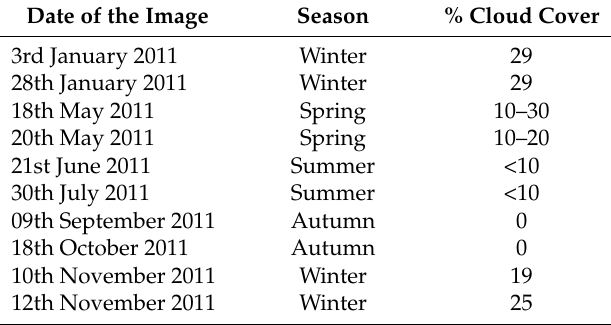
Table 3. Dates and percentage of cloud cover of NDVI images used in the